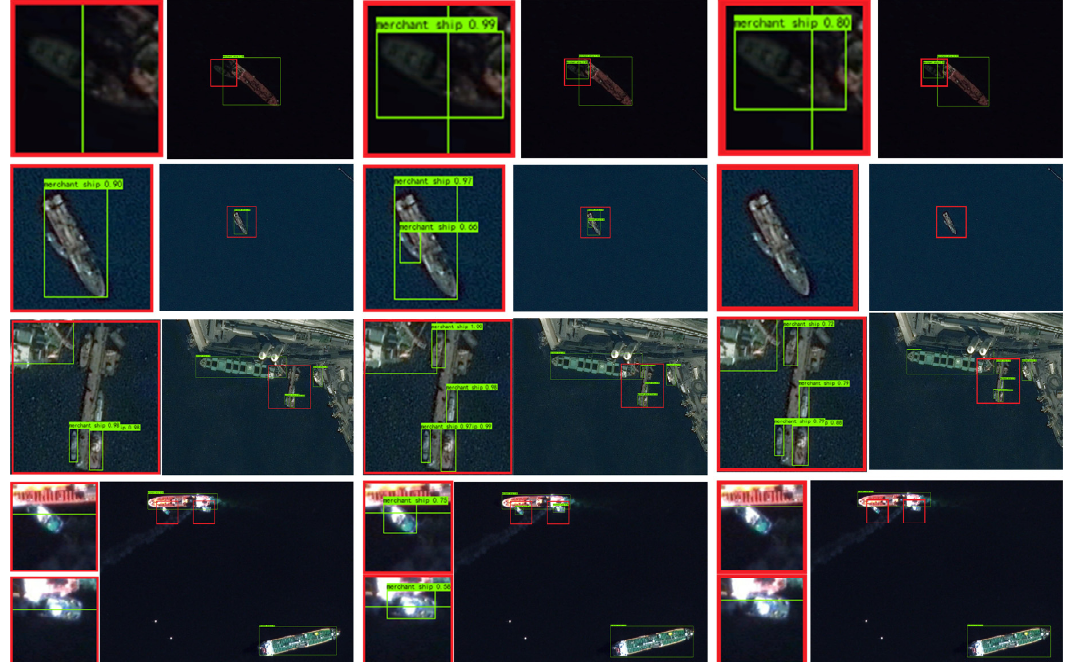
Figure 9. Small target detection effect comparison: the first column is the detection effect of the YOLOv4 model; the second column is the detection effect of our improved model; the third column is the detection effect of the YOLOv7 model.